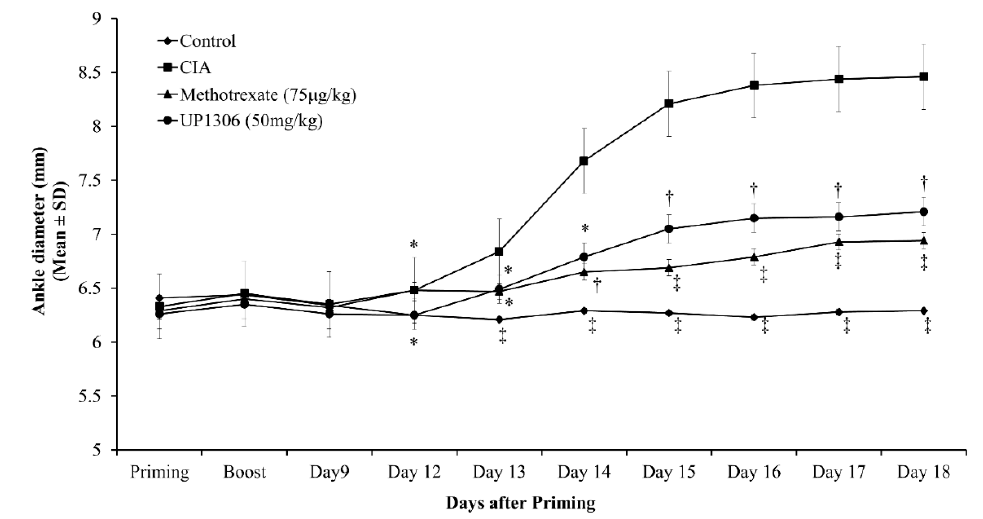
Figure 2. Changes of rats’ ankle width as a measure of arthritis severity in CIA model. Rats ( n = 10/group) were orally treated with UP1306 (50 mg/kg) and Methotrexate (75 µ g/kg) daily for three weeks post model induction. Data are mean ± SE. * p ≤ 0.05; † p ≤ 0.0001; ‡ p ≤ 0.00001 vs. CIA.